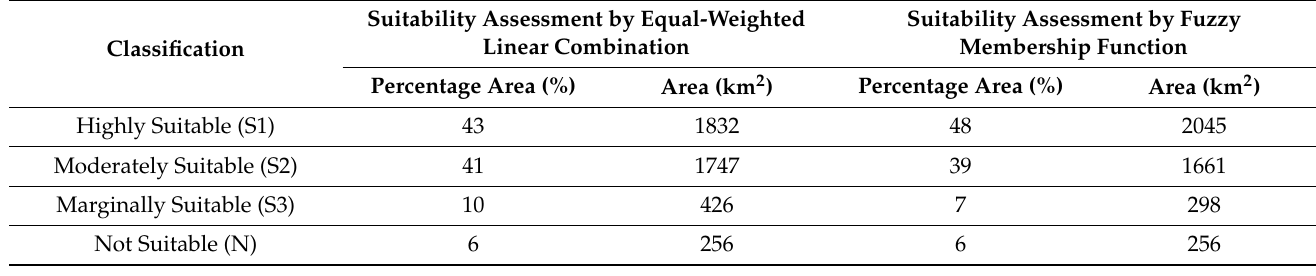
Table 4. Percentage and Area of each land suitability analysis.